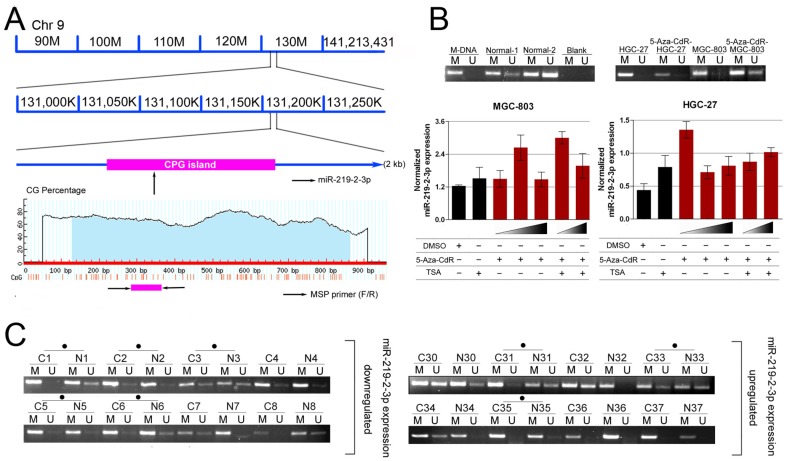
Down-regulation of miR-219-2-3p in gastric cancer cells is associated with methylation of miR-219-2-3p upstream region.(A) A schematic illustration of deletion of a segment (90 M–141 M) of chromosome 9q34.11 where the miR-219-2-3p genes located. (B) Effect of 5-Aza-CdR and TSA on miR-219-2-3p expression in MGC-803 and HGC-27 gastric cancer cell lines. 5-Aza-CdR or 5-Aza-CdR combination with TSA significantly increased miR-219-2-3p levels. (C) Representative MSP results of miR-219-2-3p methylation in primary gastric cancer tumors and normal adjacent tumor tissues. Case numbers are shown on top. M: methylated primers; U: unmethylated primers. Cases with hypermethylation were marked.